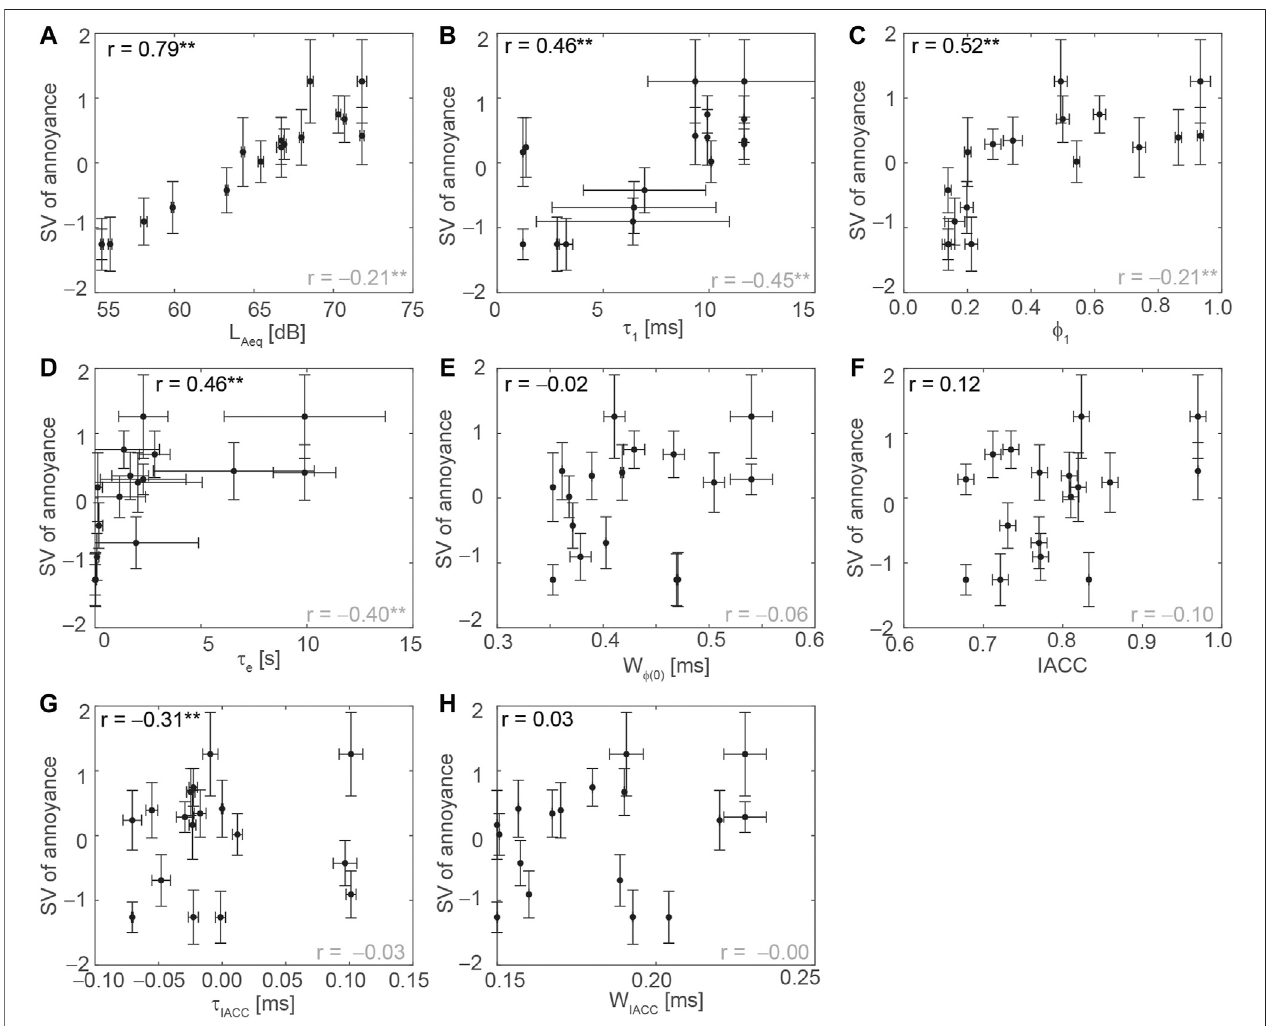
FIGURE 8 | Relationship between correlation parameters and the scale values of annoyance. (A) L Aeq , (B) τ 1 , (C) ϕ 1 , (D) τ e , (E) W ϕ (0) , (F) IACC, (G) τ IACC , and (H) W IACC . The symbols indicate the mean values and the error bars indicate the SDs. The correlation coef fi cients of the mean and SDs are shown in black and gray, respectively. Asterisks represent the level of signi fi cance, i.e., ** p < 0.01, * p < 0.05.